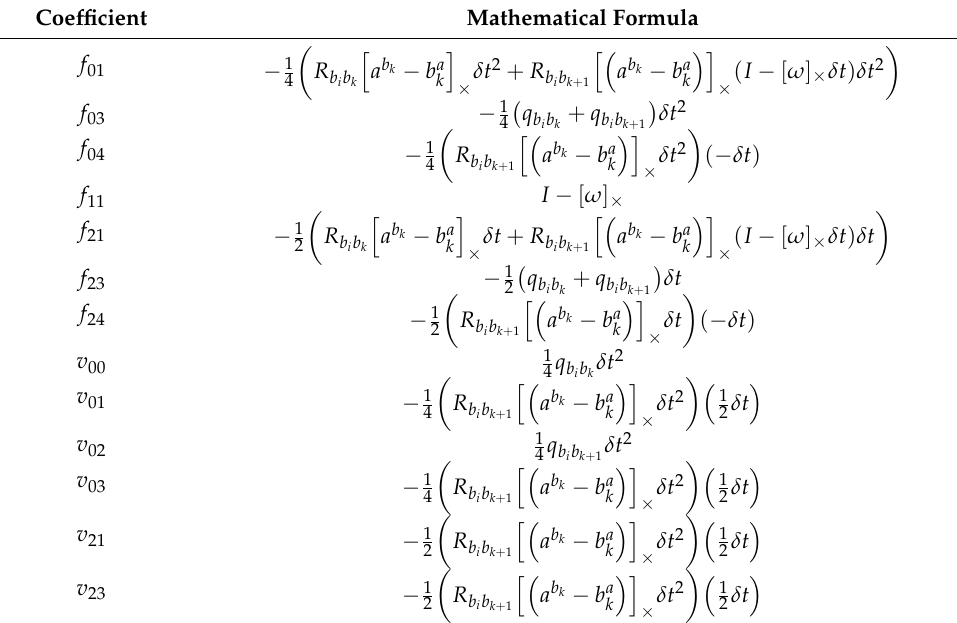
Table 1. The parameters in matrix F t , G t